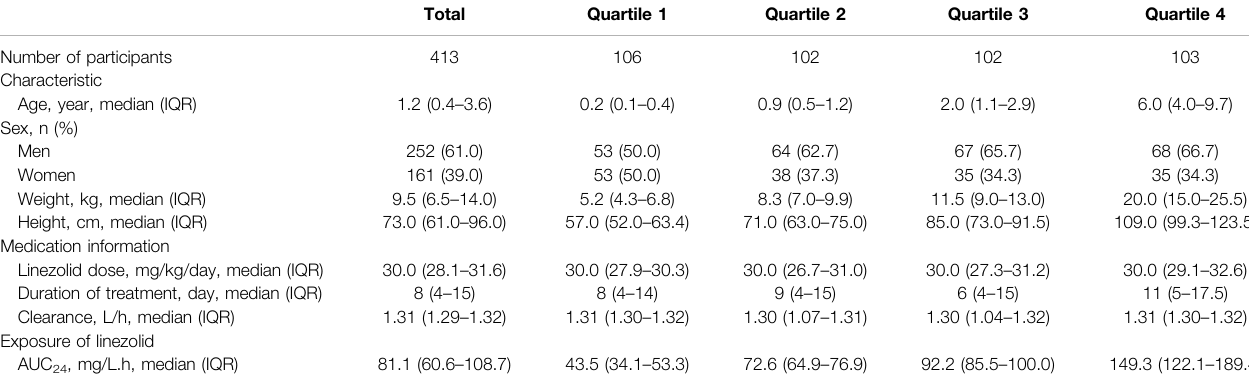
TABLE 2 | Demographic characteristics, medication information, and exposure of linezolid according to the AUC 24 quartile ( n =